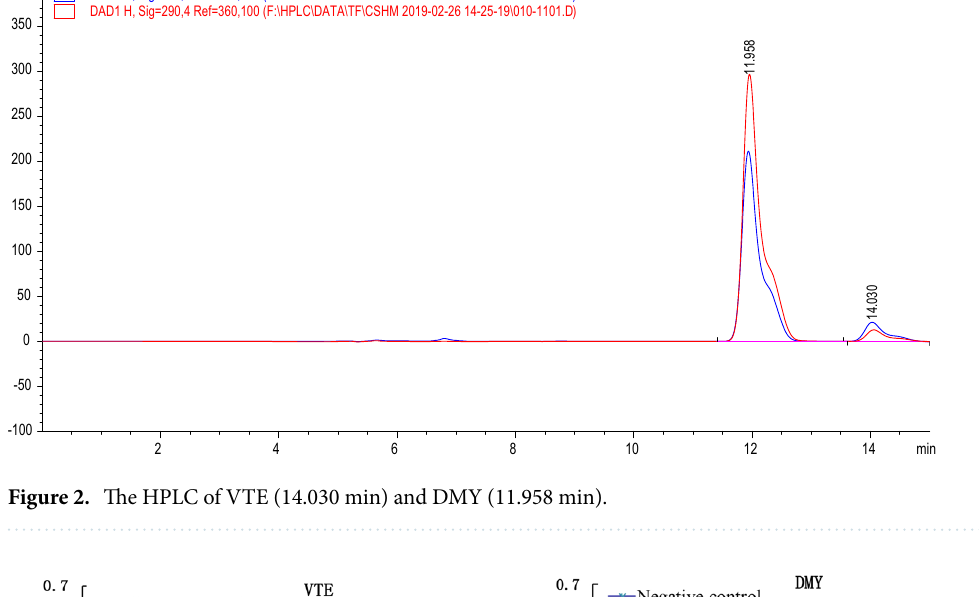
Figure 2. The HPLC of VTE (14.030 min) and DMY (11.958 min).